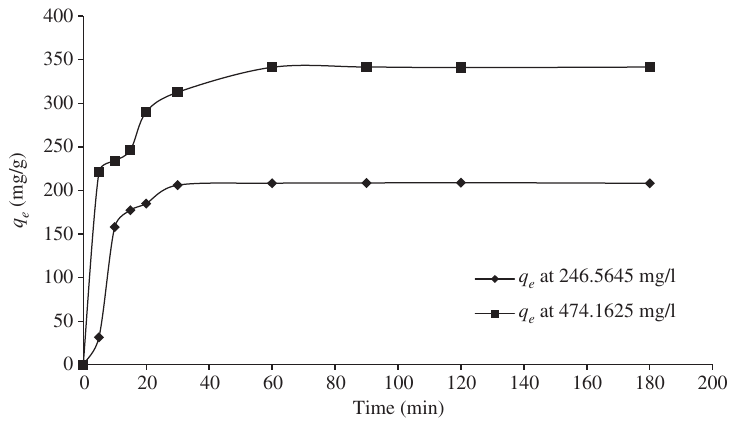
Figure 3: Effect of contact time on adsorption capacity of Pb(II) onto S. sesban L. at 30 ° C. [Adsorption conditions employed: Pb(II) ion concentrations, 247, 474 mg/l; pH, 4.5; adsorbent concentration, 0.3 g/l; adsorption tempera- ture, 30 ° C; particle size, 50–150 μ